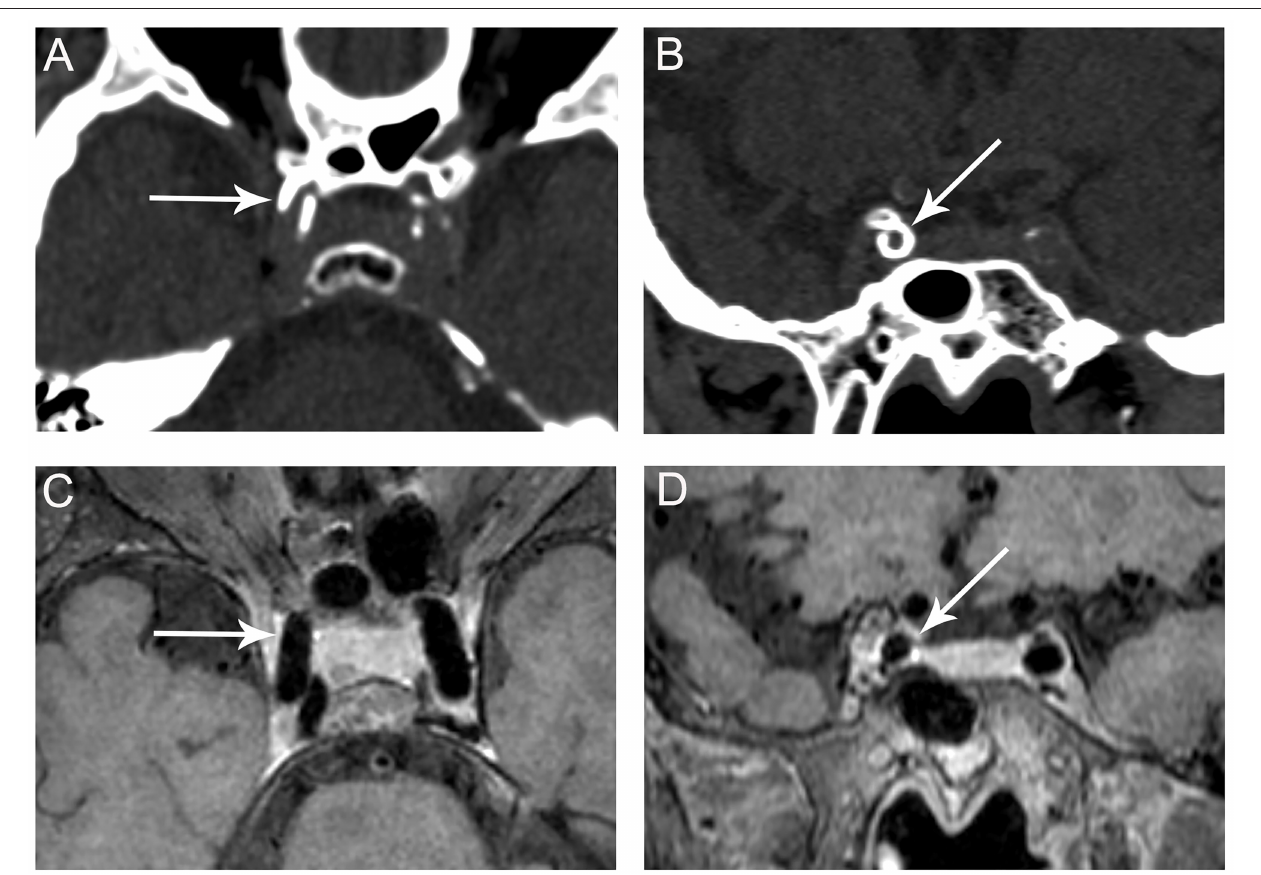
FIGURE 3 | Representative images of predominant medial ICA calcification. CT shows a continuous, circumferential calcification on the long ( A , arrow) and short axes ( B , arrow) of the right cavernous segment of the ICA suggesting medial calcification. No corresponding plaque is observed on VWMRI ( C , D , arrows).